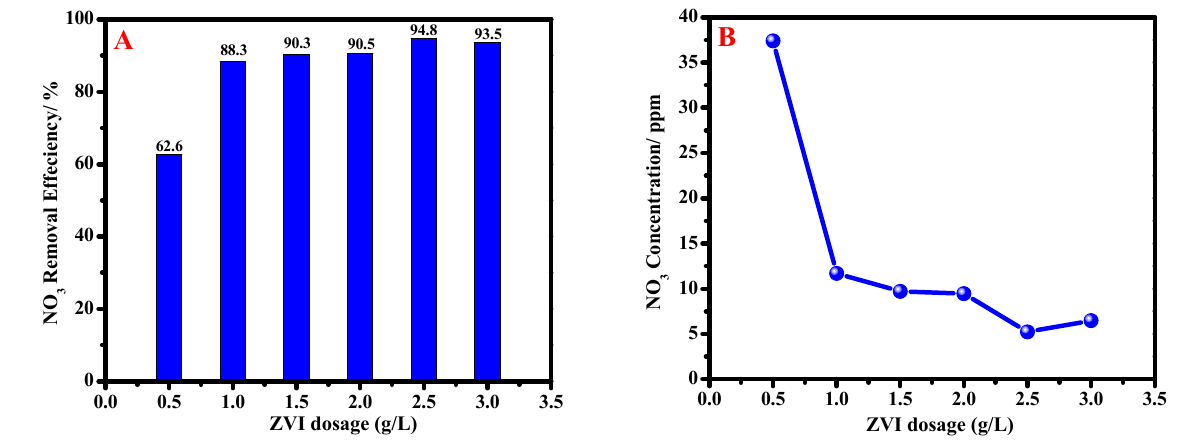
Figure 5. Nitrates removal efficiency versus the dosage of nZVI ( A ) and Nitrate concentration after treatment with different ZVI dosages ( B ) at ambient temperature and 30 min contact time.